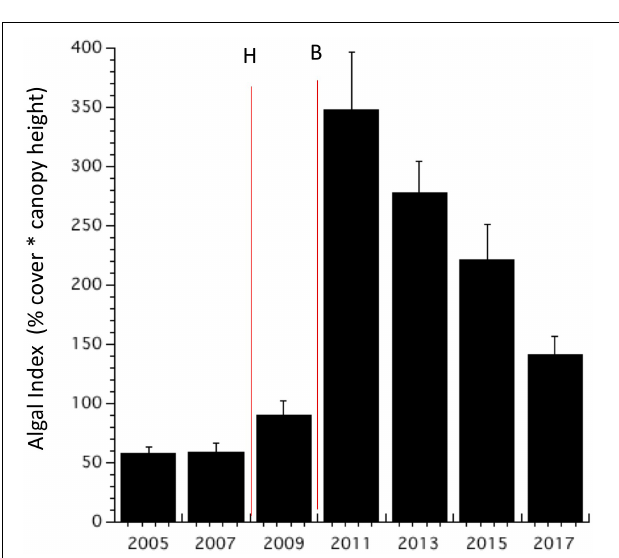
FIGURE 3 | Algal biomass proxy, called the "algal index" (percent cover times canopy heights for all algae) at monitored sites from 2005 to 2017 (mean + SE). For comparison, the mean algal index across 12 islands of the Eastern Caribbean (i.e., 882 ± 58 SE; Steneck et al., 2018) was more than twice the maximum value recorded for Bonaire in 2011. Vertical lines denote the hurricane (H) and bleaching (B) events.